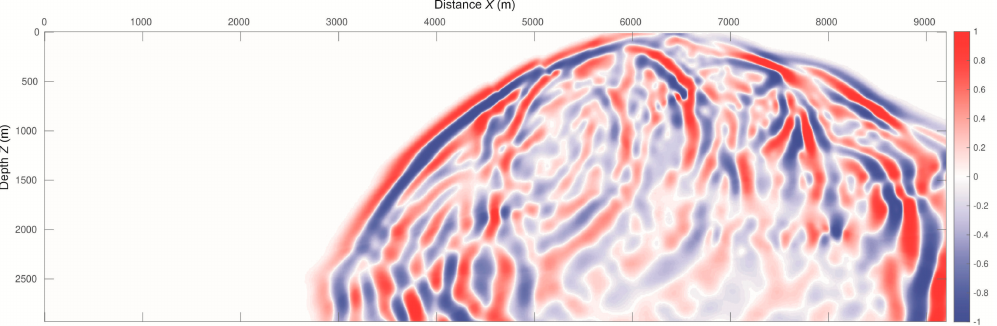
Figure 5. Snapshots computed after a 1 s simulation of the acoustic wave equation in the two-dimensional Marmousi model. The visualization was made using the normalized and enhanced value of component v x